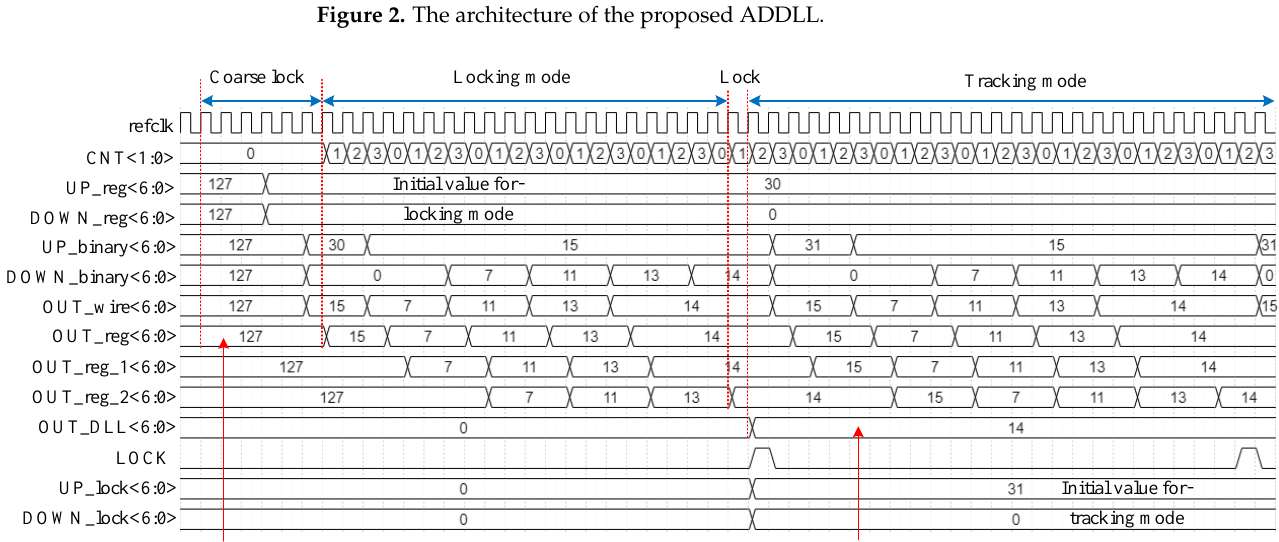
Figure 3. The timing diagram of the proposed